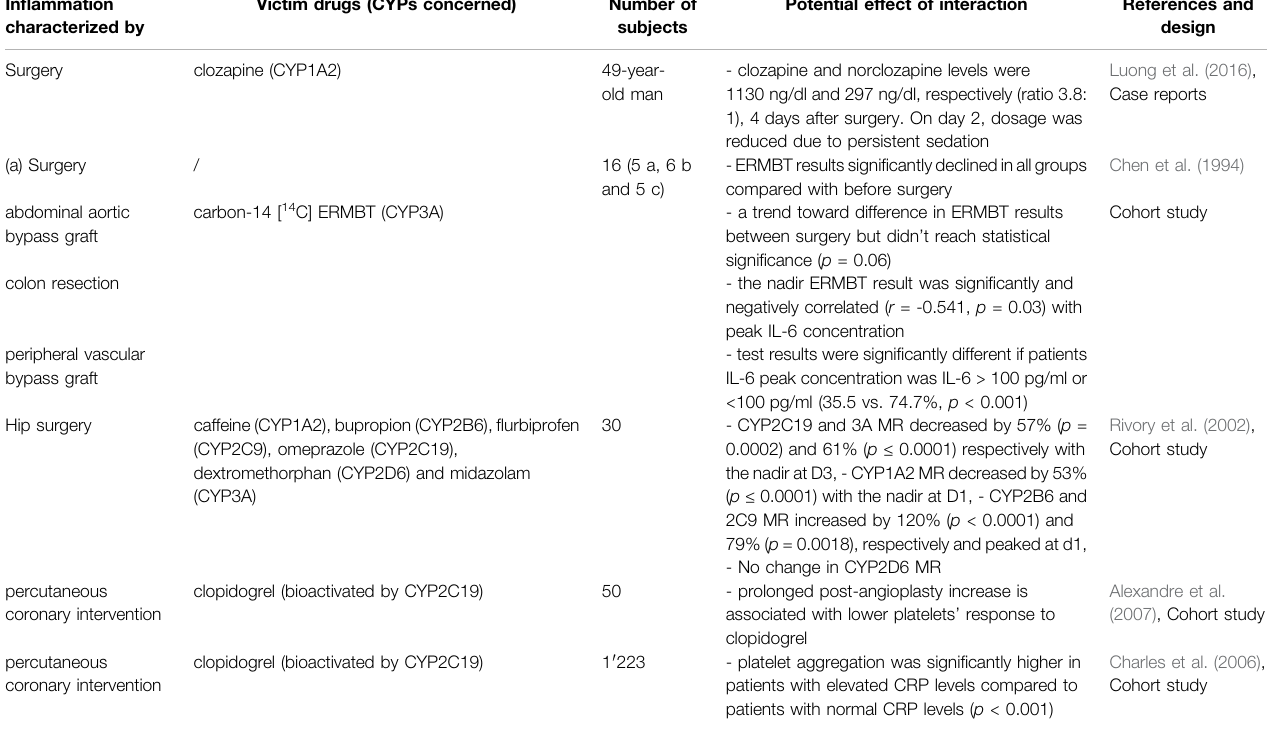
TABLE 11 | Impact of surgery on CYP substrates, explained totally or partially by modulation of CYP activity. In fl ammation characterized